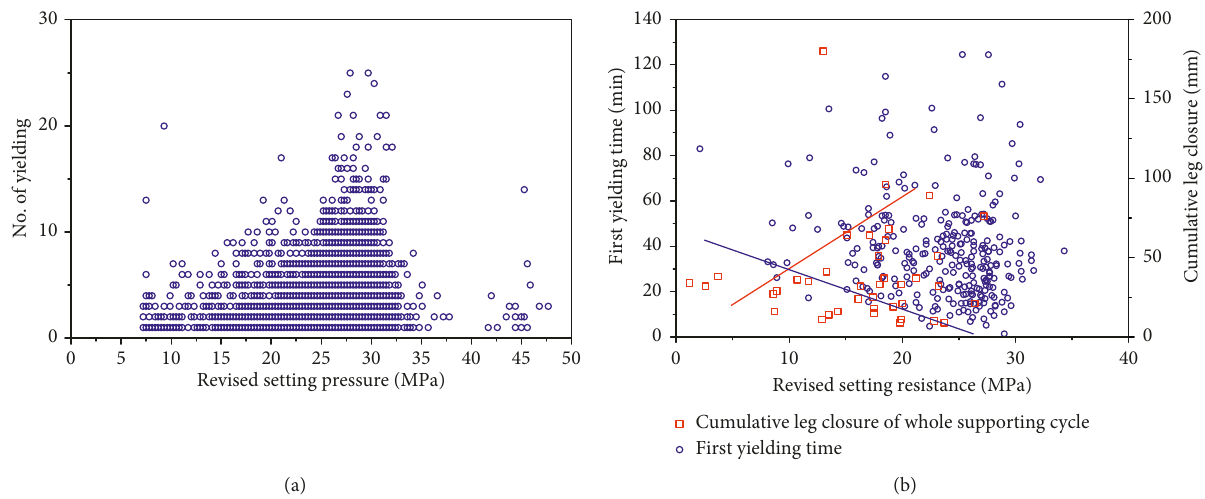
Figure 10: Effect of setting pressure on yielding characteristics. (a) Number of yielding and (b) first yielding time and cumulative leg closure versus revised setting